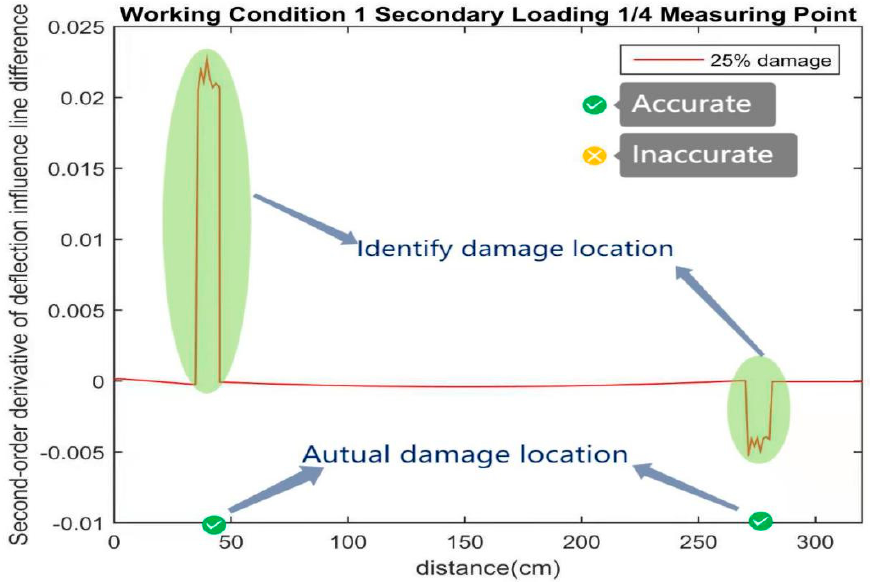
Figure 35. The second-order derivation of deflection influence line difference at 25/100 measuring point of the first span under work condition 4.